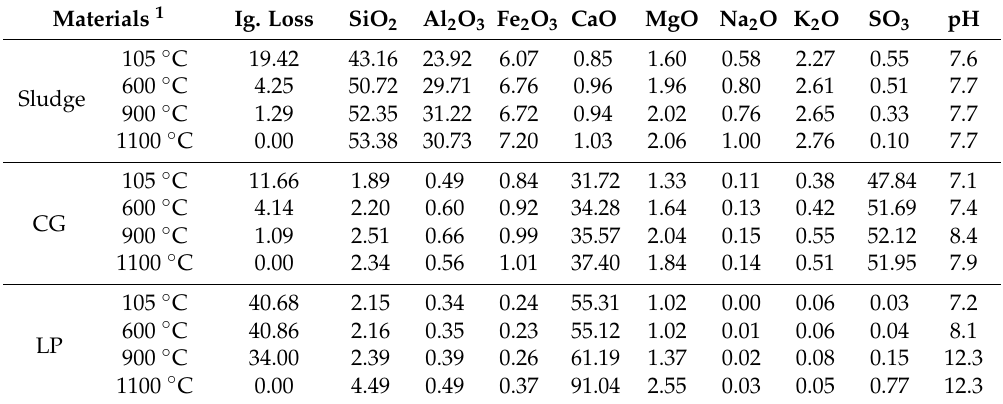
Table 2. Change in chemical composition of individually burnt raw materials according to the type of activator (%).